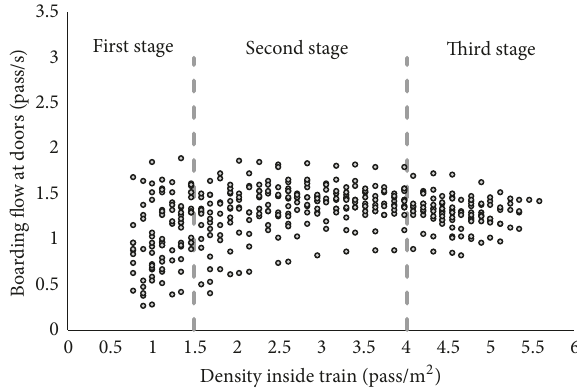
Figure 8: Relationship between the flow of passengers boarding at the doors and the density inside the train at PAMELA in the case of LC 2 (R =